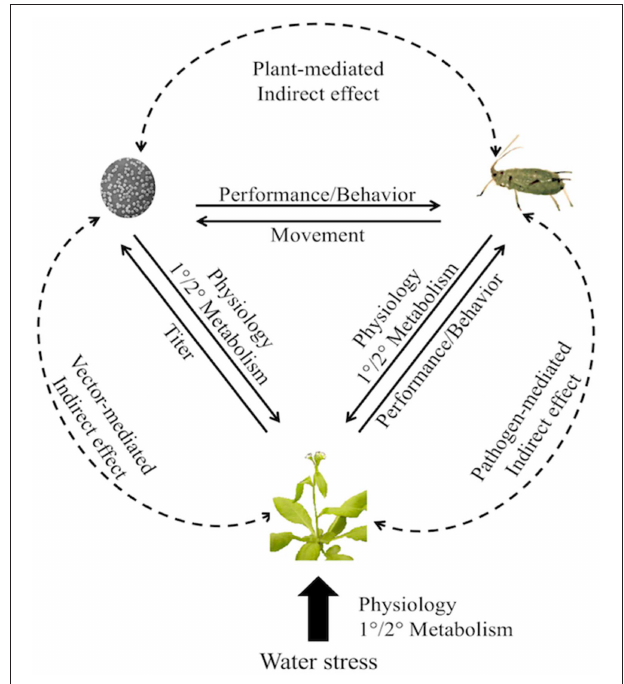
FIGURE 1 | Direct and indirect interactions among insect vectors, pathogens, and drought-stressed host plants, with examples of responding traits. Solid lines are direct effects, dashed lines are indirect effects. Arrows indicate the effect of one factor on another. Water deficit affects plant primary (differentiation) and secondary (defense) metabolism. These changes can alter reciprocal direct and indirect feedback among the plants, vectors, and pathogens and result in changes in performance and behavior of the vectors and